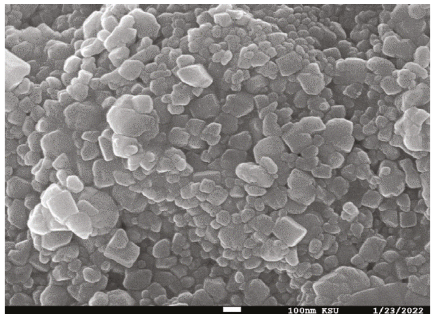
Figure 17: SEM image of Cr